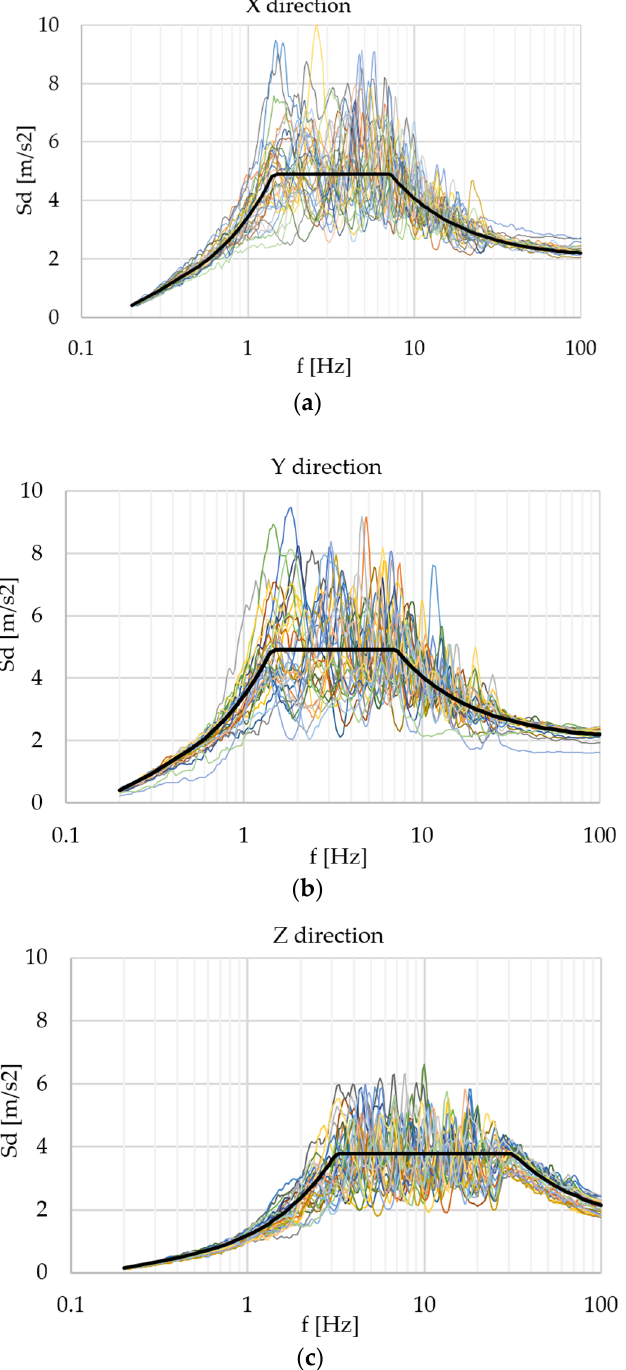
Figure 12. Response spectra of generated time histories for the three main directions: ( a ) X; ( b ) Y; ( c )